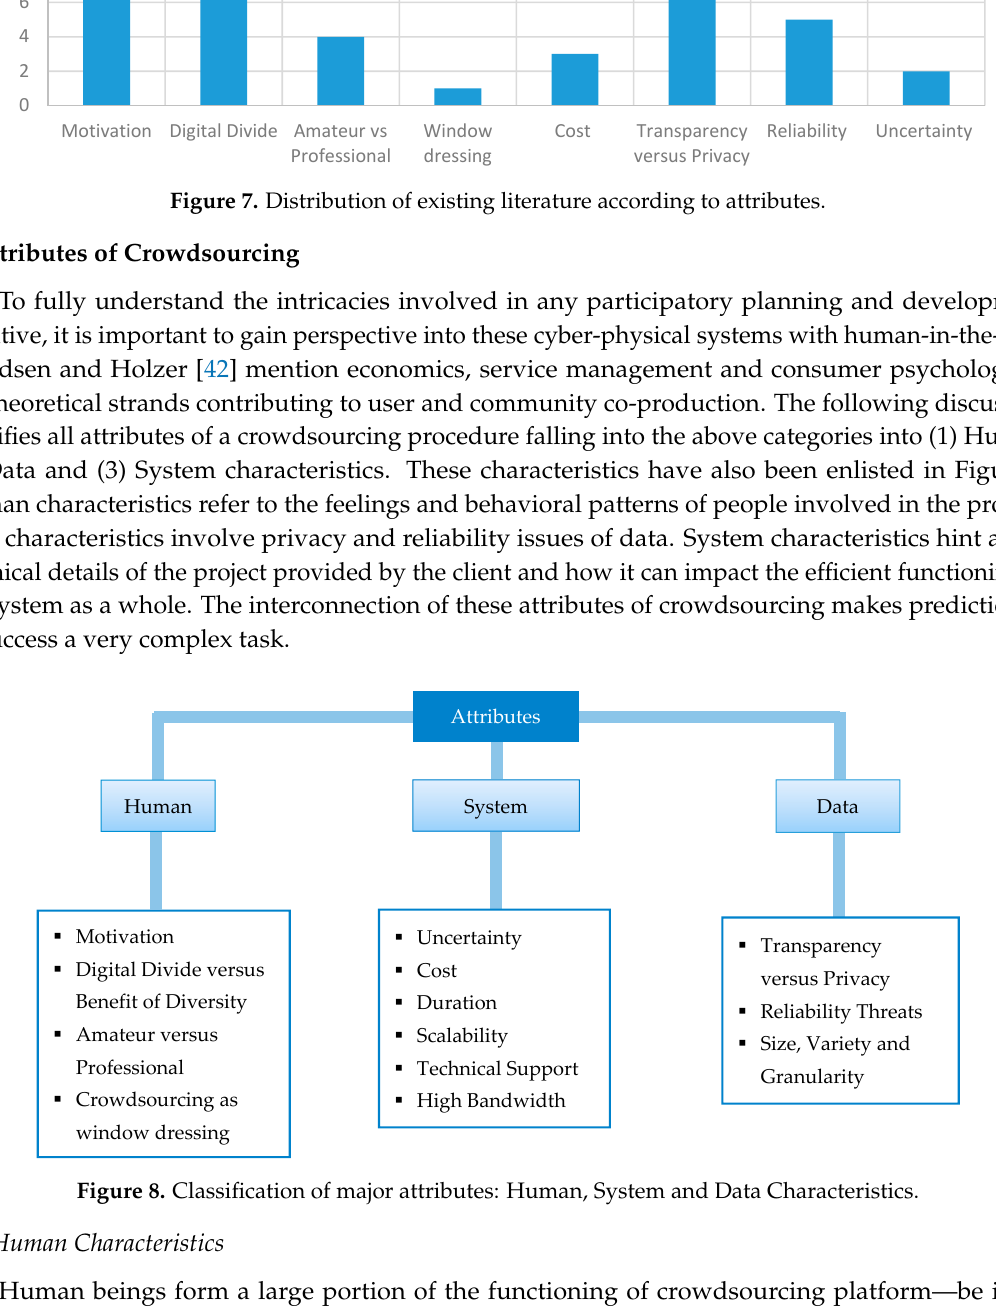
Figure 7. Distribution of existing literature according to attributes.